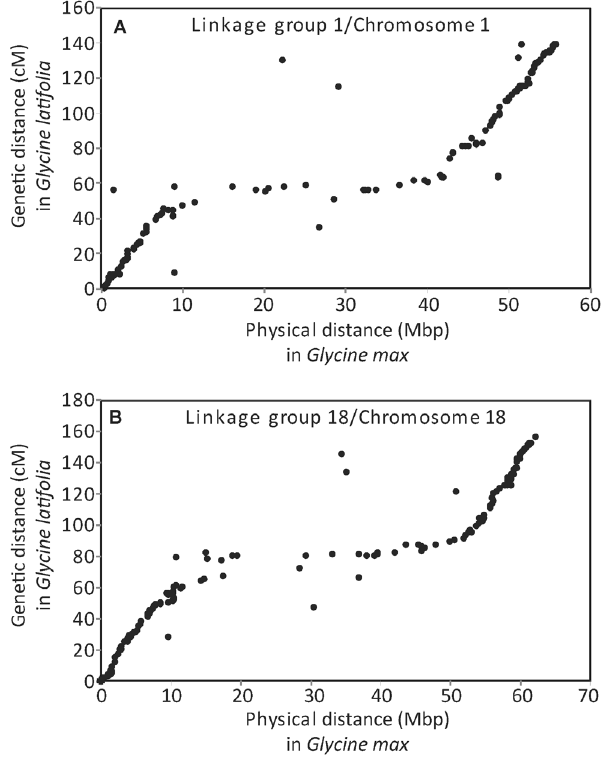
Figure 3. Comparison of genetic distances in Glycinelatifolia to physical distances in G.max for linkage groups/chromosomes 1 and 18. Glycine latifolia linkage groups 1 and 18 showed a high degree of collinearity with the corresponding G. max chromosomes. The genetic distances in G. latifolia were plotted against the physical locations of the SNP markers on the G. max chromosomes 1 and 18. As in G. max , the predicted ratios of genetic and physical distances varied along G. latifolia linkage groups. The slopes were steeper near the ends of linkage groups and flatter near the center in regions predicted to correspond to centromeres, where recombination is lower.